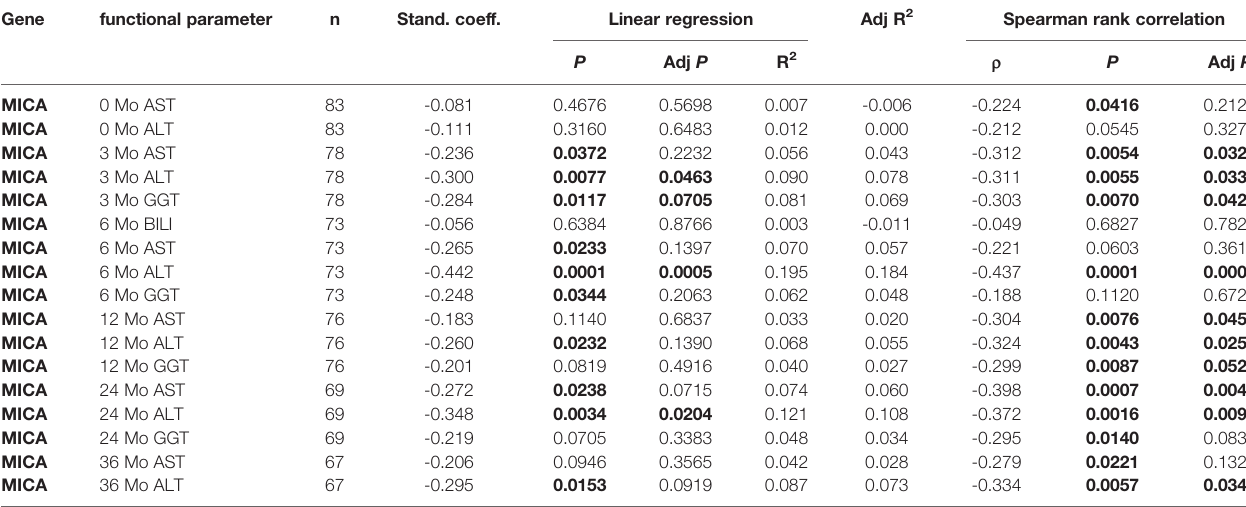
TABLE 2 | Univariate linear regression and correlation analysis depicting the predictive power of MICA post liver transplantation. Gene functional parameter n Stand.